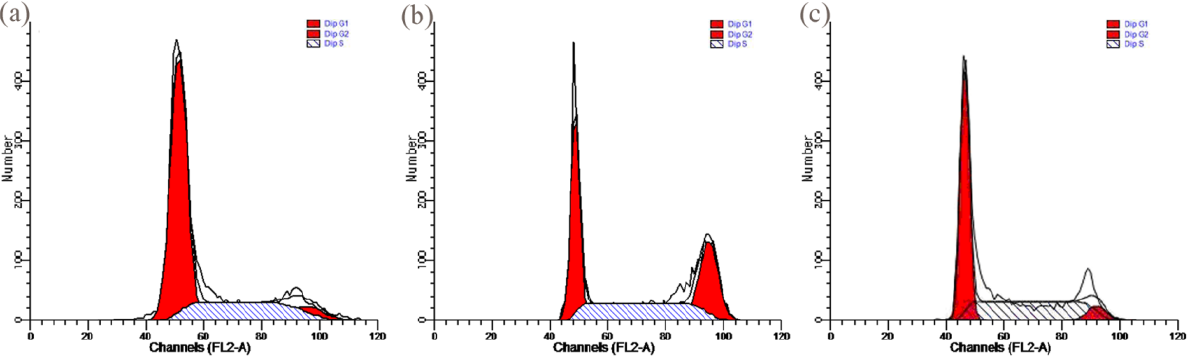
/M = 29.23%. (c) DNA histogram from Caski 2